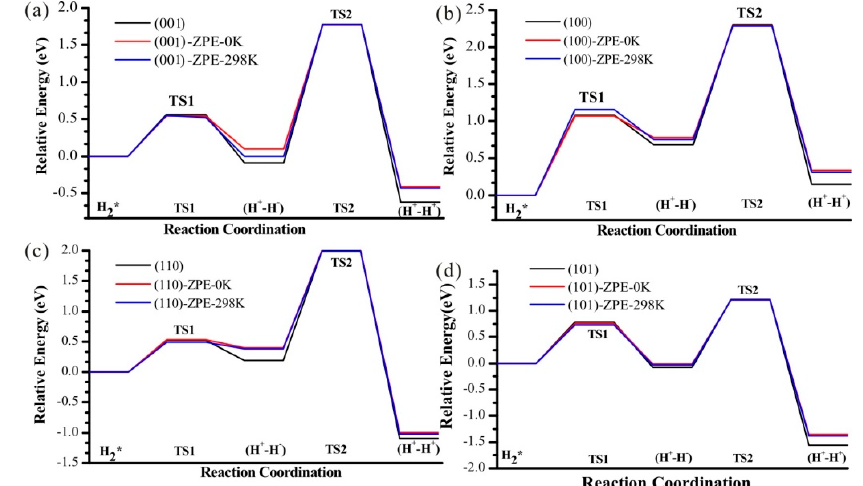
Figure 11. The heterolytic pathway of H 2 dissociation and subsequent H transfer from Ti to O nearby on four (a-d) TiO 2 facets, considering zero point energy (red lines). Blue lines indicate the profiles for T = 298 K.